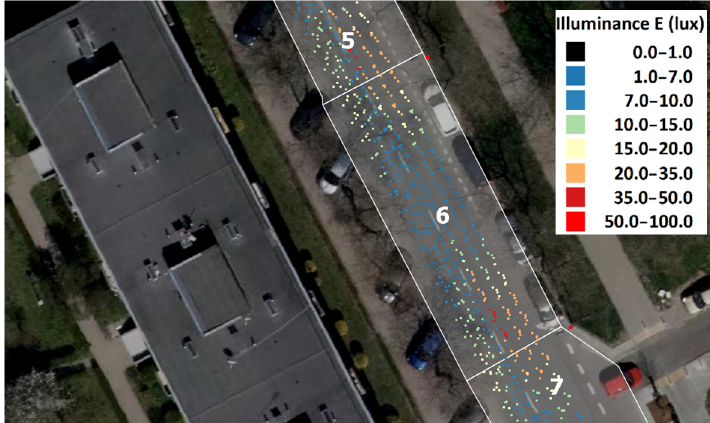
Figure A4. Example of five illuminance measurements in field No. 6.